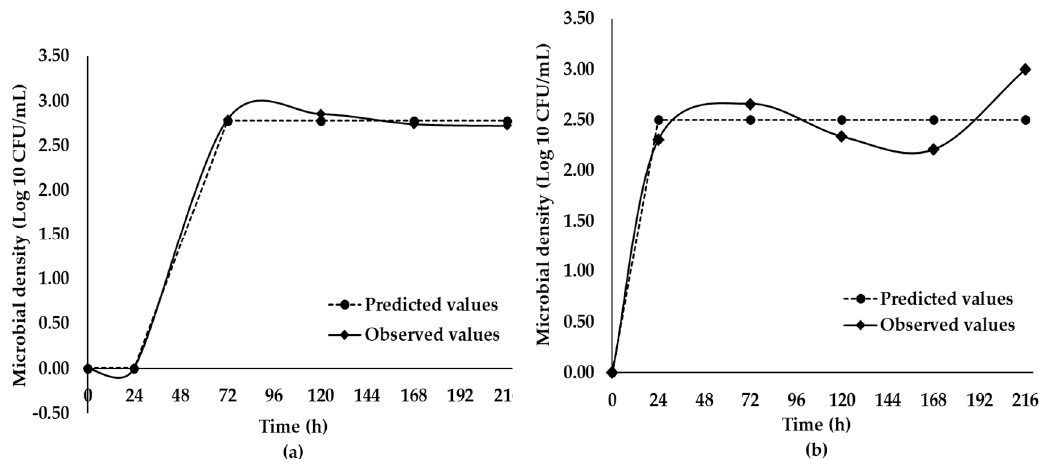
Figure 2. Comparison of the predicted and observed nonpathogenic tlh + ( a ) and pathogenic tlh +/ tdh + ( b ) V. parahaemolyticus strain growth in tryptone soy broth during refrigerated storage at 7 ± 1 ◦ C for 216 h (9 days). The strains were isolated from live oysters ( Crassostrea virginica ) at 0 h. Predicted growth values were fitted using Equation (1).